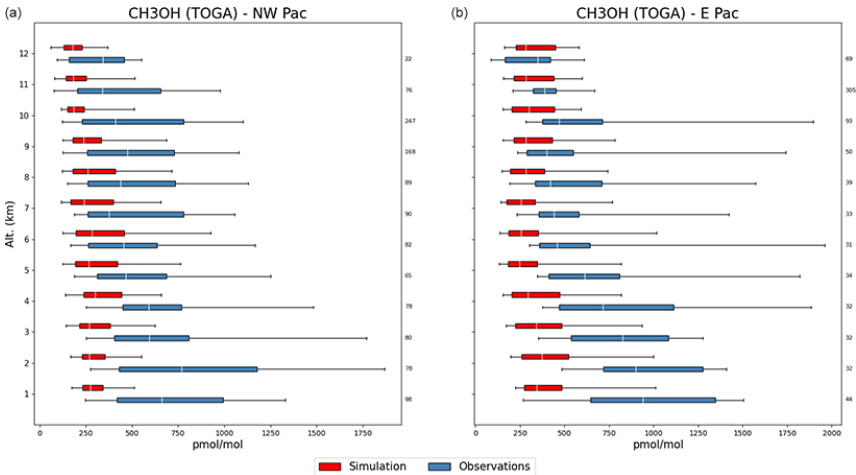
Figure 9. Vertical profiles of CH 3 OH of model simulations and ATom observations over the Pacific region (region 1 in Fig. 2) in the Northern Hemisphere, represented by box and whisker plots for altitude bins. The white line marks the median, the box corresponds to lower and upper quartiles, and the whiskers represent the 5th and 95th percentiles. The numbers on the right indicate the number of points of interest (POI, averaged values for region, flight and altitude) considered for each altitude